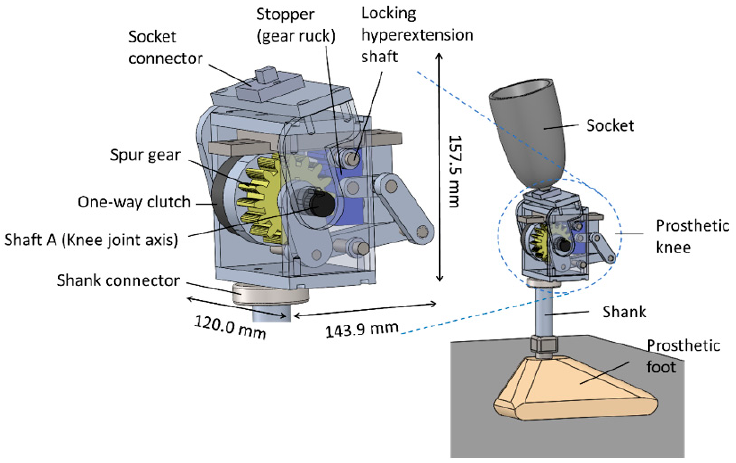
Figure 1. CAD models of the transfemoral prosthesis assembly and the proposed prosthetic knee.